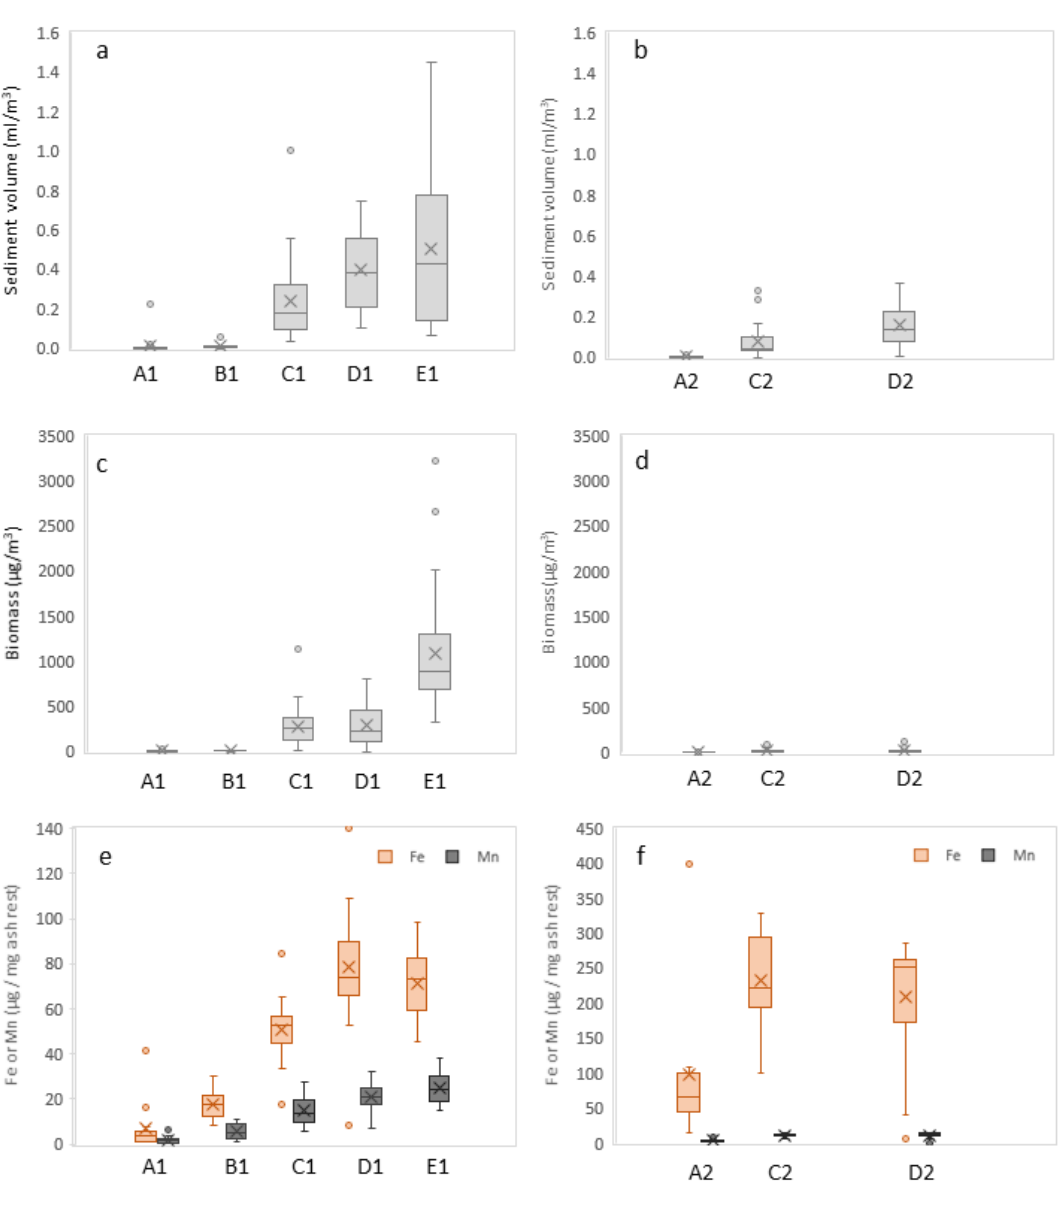
Figure 7. Variations from the treatment plant (A) to downstream distribution locations (D, E) of ( a , b ) sediment volume, ( c , d ) biomass and ( e , f ) Fe and Mn content in particulate material collected in the study system (left graphs, a , c , e ) and in the reference system (right graphs, b , d , f ) over 8 months. Sediment was collected at all locations in filters in place for one to two weeks (Table 1), and the results were normalized to a cubic meter of filtered water. Box plots represent the median, lower and upper quartiles of data collected over the study period (Table 1).